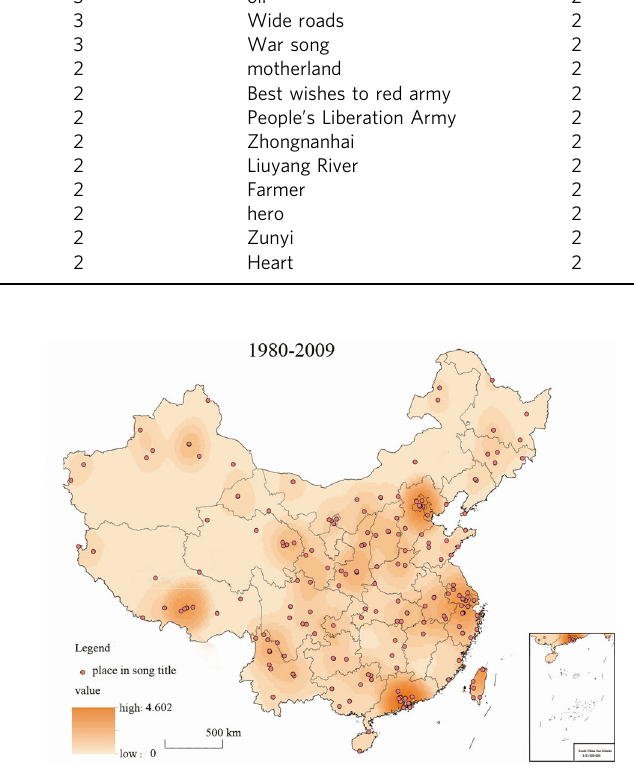
Fig. 4 Kernel density estimation of place in music in 1980 – 2009. Kernel density estimation of place in music titles from 1980 to 2009 indicates that the darker areas are distributed primarily in the Beijing, Yangtze River Delta, Pearl River Delta, and Lhasa. These places are frequently referred to in song titles, forming a